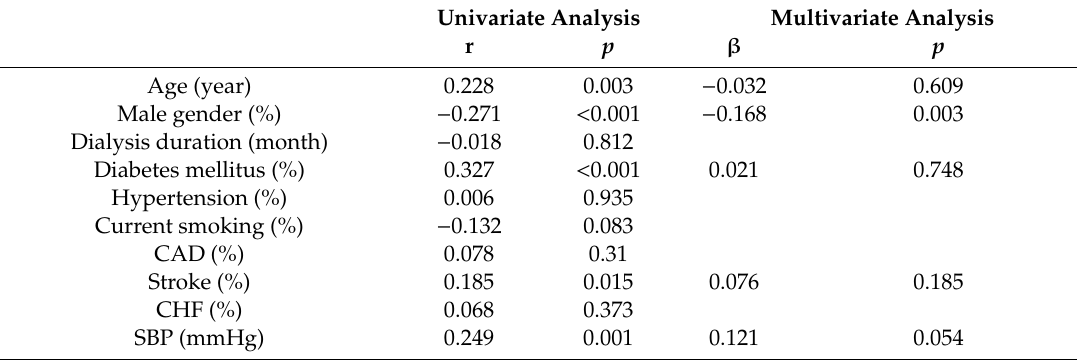
Table 2. Univariate and multivariate correlates of %MAP in study